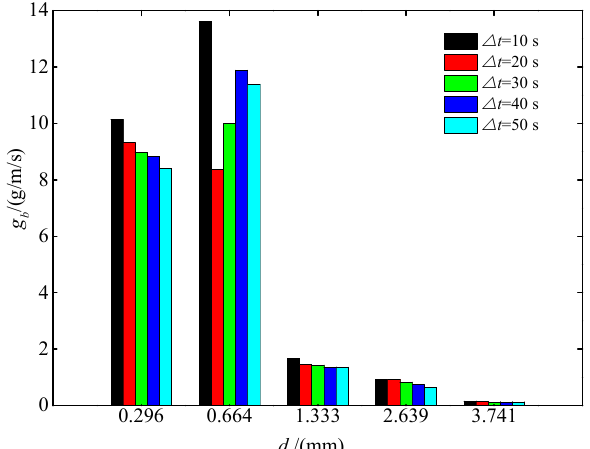
Figure 5. Variation of sediment transport rate of five uniform sands with different sediment particle sizes under unsteady flow conditions.